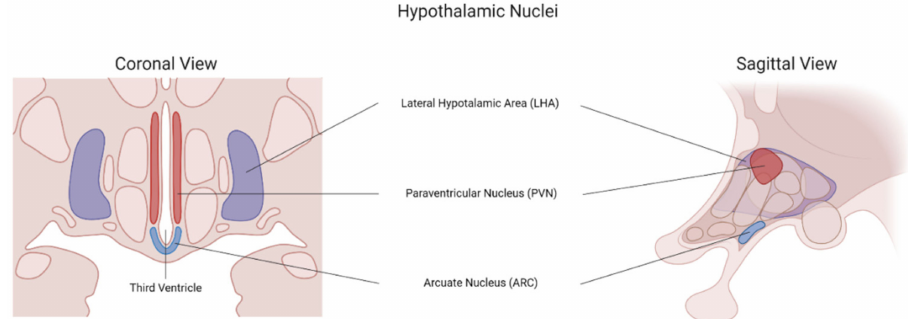
Figure 2. Hypothalamic nuclei in food intake regulation. Coronal and sagittal